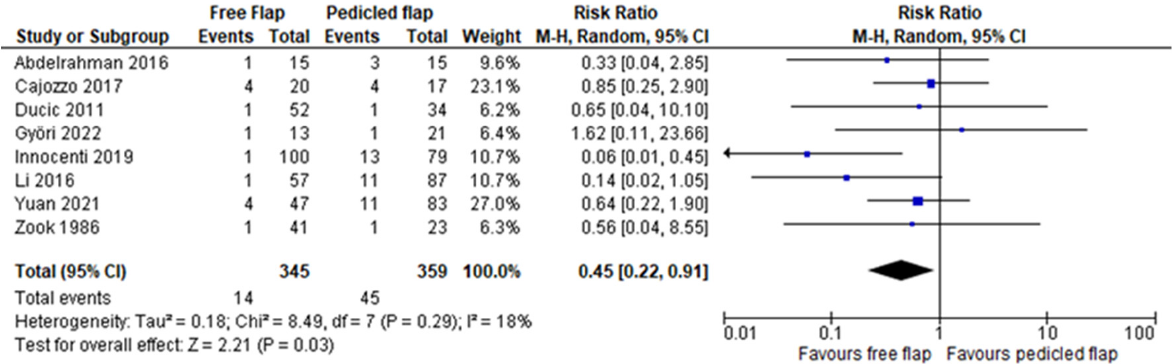
Figure 3. Partial flap necrosis meta-analysis [12–16,18–20].